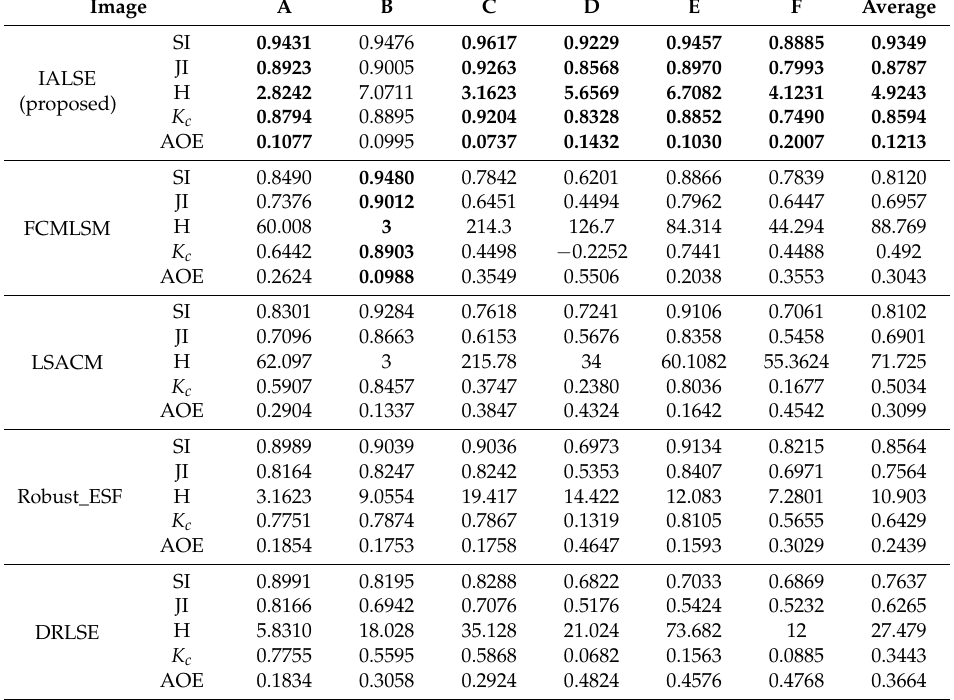
Table 1. Calculation data of comparison methods and proposed method.